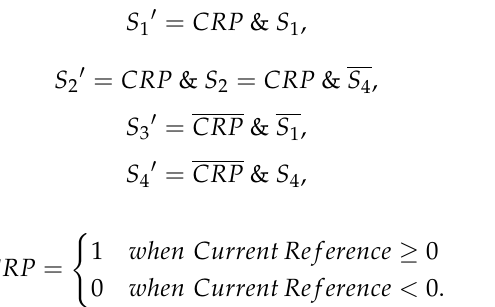
Figure 6. Logical diagram of the proposed switching scheme. Table 2. Conduction mode.